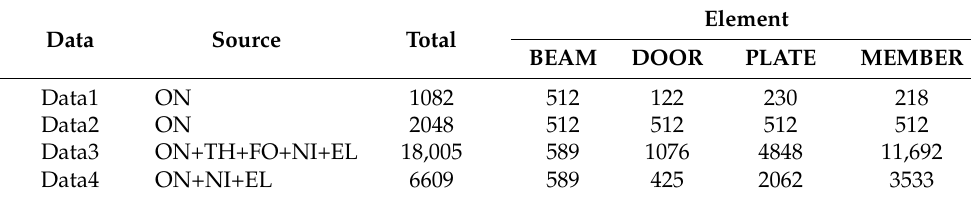
Table 4. Overview of data set.